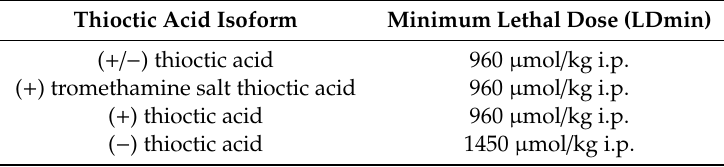
Table 1. Minimum lethal dose of i.p. injected (+/−) thioctic acid, (+) and (−) enantiomers.